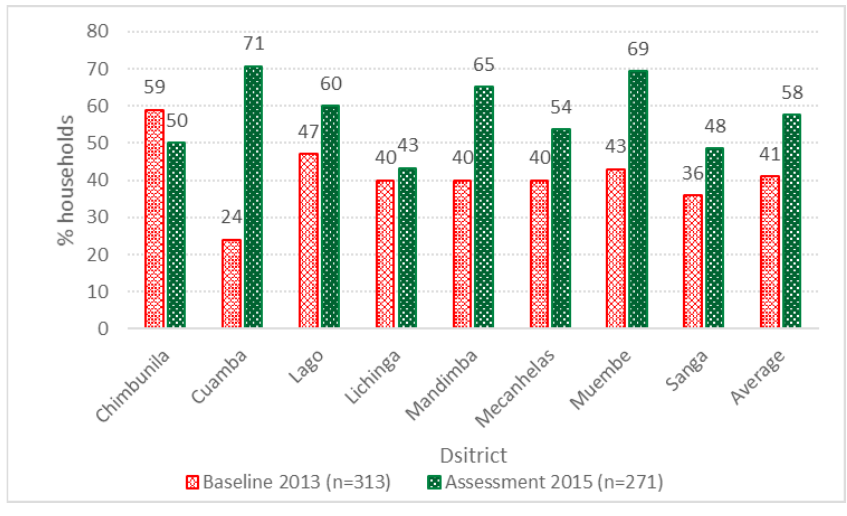
Figure 4: OFSP vine conservation at lowland